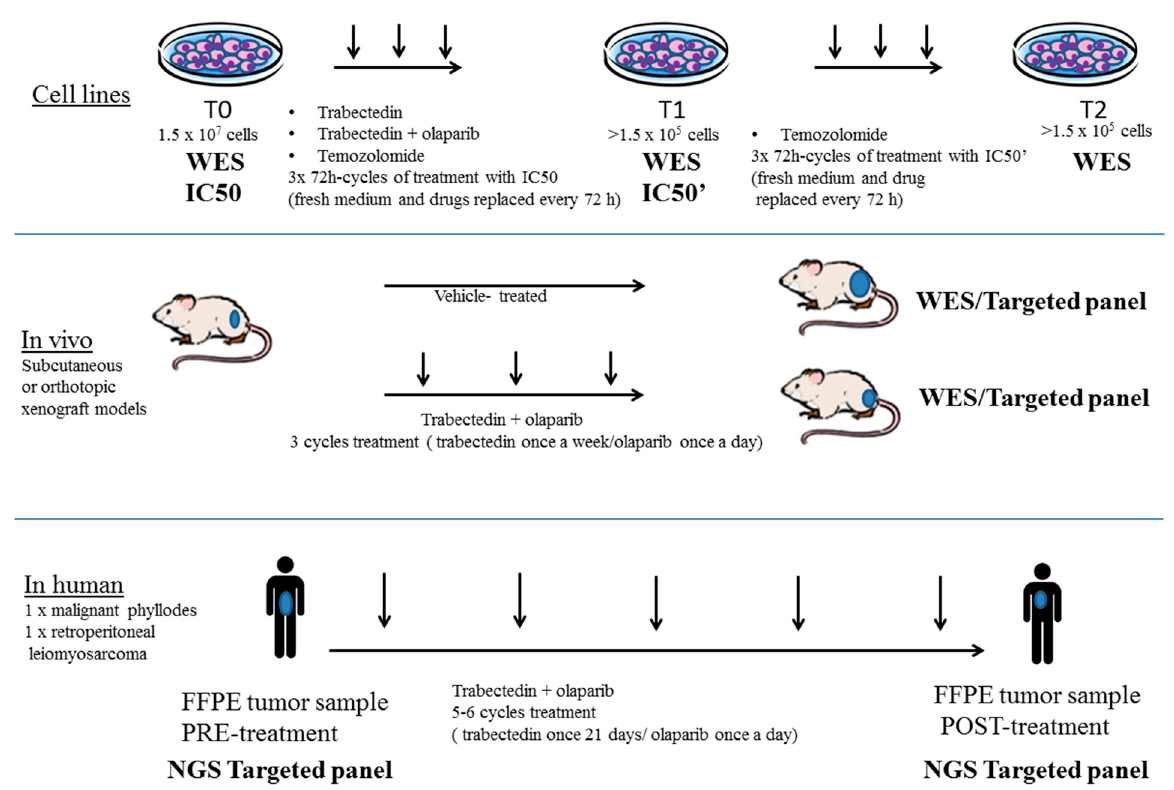
Figure 1. Experimental workflow on preclinical and translational platform. In vitro models ( n = 9 for trabectedin + olaparib treatment): cell lines underwent 3 cycles of drug treatment as described in the Methods section followed by DNA extraction and WES analyses (T1). After 3 cycles of treatment (T1) no sufficient cells survived trabectedin and olaparib treatment. Temozolomide-treated cells ( n = 5) underwent another cell viability test, showing increased resistance. After establishing a higher IC50 (IC50 ′ ), surviving cells ( n = 1) underwent 3 novel cycles of temozolomide treatment, followed by DNA extraction (T2). In vivo models ( n = 3): DMR, HT1080 and SJSA-1 were injected into the right flank or into the uterine wall (orthotopic model: DMR only) of NOD/SCID mice. After tumor engraftment, mice were treated with trabectedin + olaparib for 3 weeks or left untreated. Patient samples ( n = 2): two patients enrolled in the TOMAS trial, affected by advanced sarcomas, were treated with trabectedin and olaparib combination at the recommended phase 2 dose. Extracted DNA (pre and post treatment) was analyzed by next-generation sequencing approaches: WES or targeted panel (Oncomine TML) scalable in low DNA concentration and FFPE conditions.